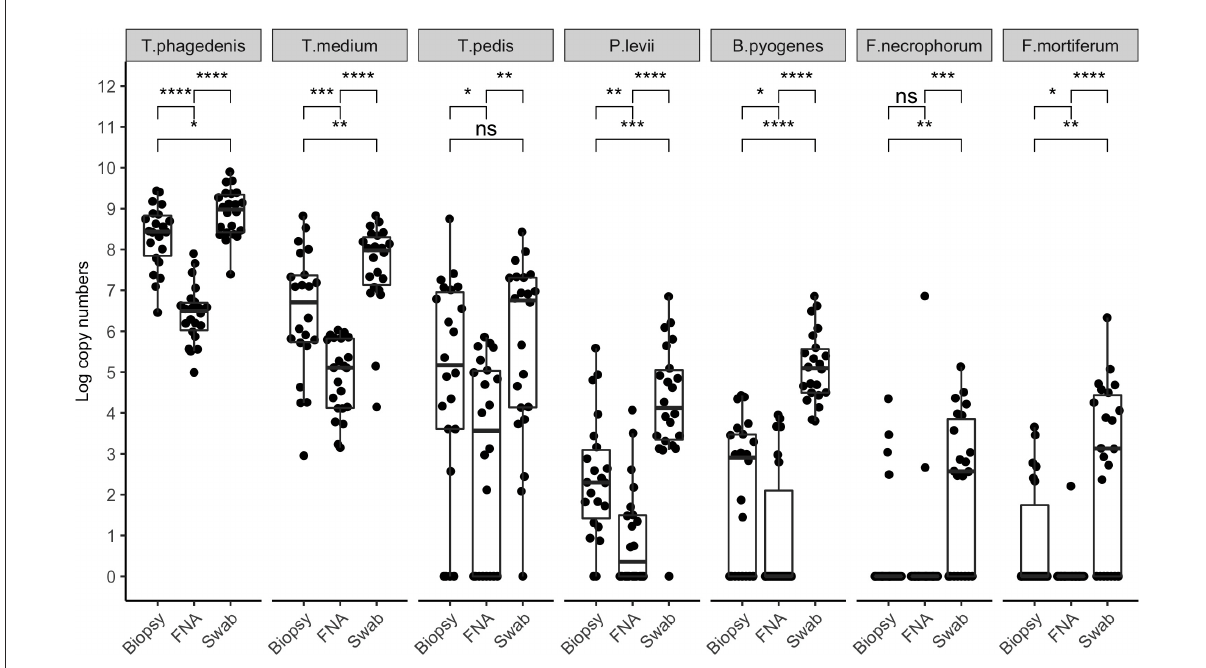
FIGURE2 Bacterial quantification (log copy numbers) by species for each sampling method. Boxplot showing the distribution of data, with each dot representing one sample ( n = 22). Related p -values for Dunn’s post–hoc test among the sampling methods: biopsy, fine-needle aspiration (FNA), and swab for Treponema phagedenis , Treponema medium, Treponema pedis, Porphyromonas levii, Bacteroides pyogenes, Fusobacterium necrophorum , and F. mortiferum . No significant difference was observed for T. pedis between biopsy and swabs, and F. necrophorum in biopsy and aspirates only. Asterisks and horizontal bars indicate differences in bacterial quantification among the sampling methods: ns: p > 0.05, * p < 0.05, ** p < 0.01, *** p < 0.001, **** p < 0.0001.